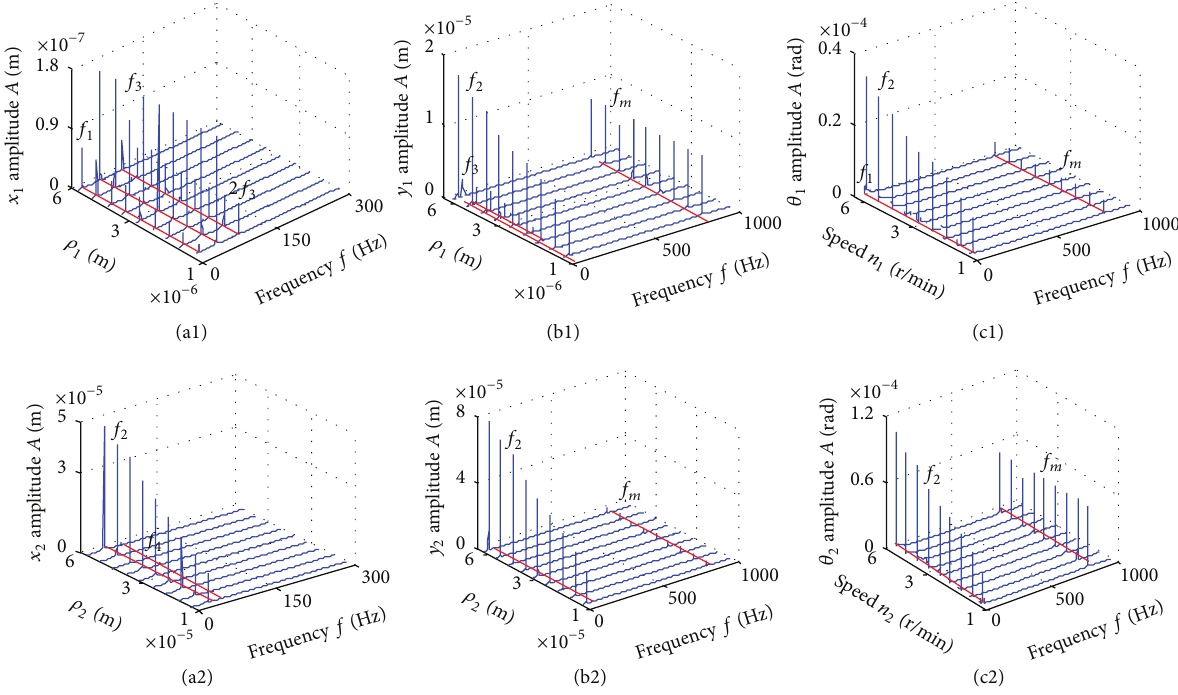
Figure 11: 3D frequency spectrum of the gears in lateral and torsional